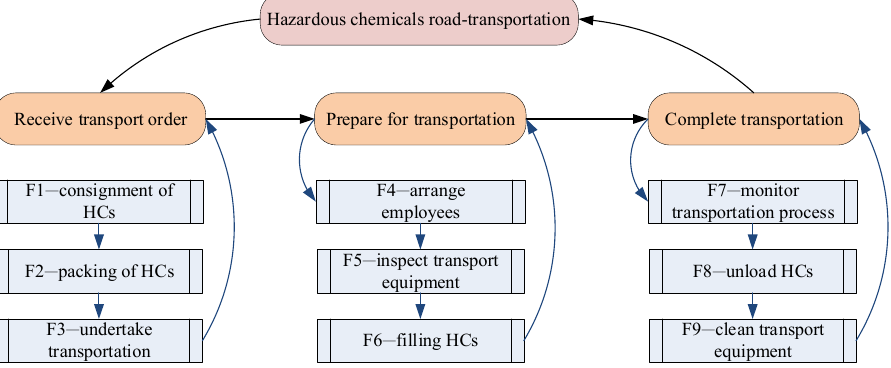
Figure 4. Decomposing the functions of HCRTS by HTA.